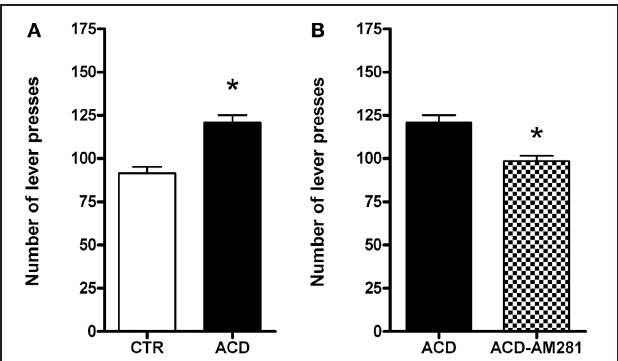
FIGURE 2 | Effects of ACD (A) and AM281 treatment (B) on the number of lever presses during the extinction day. Each value represents the means ± S.D. of 16 rats. ∗ p < 0 . 001 vs. respective control groups.